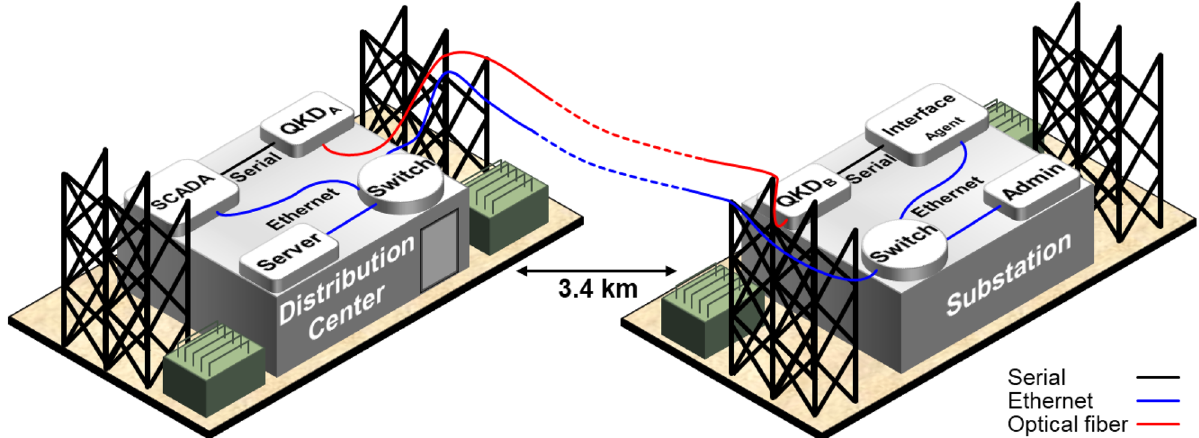
Figure 4. Illustration of the network configuration. The distribution center contains the QKD Alice system, SCADA (Supervisory control and data acquisition) system, and a server to collect network statistics. The substation contains the QKD Bob system, the energy storage system Interface agent, and an admin computer for real-time